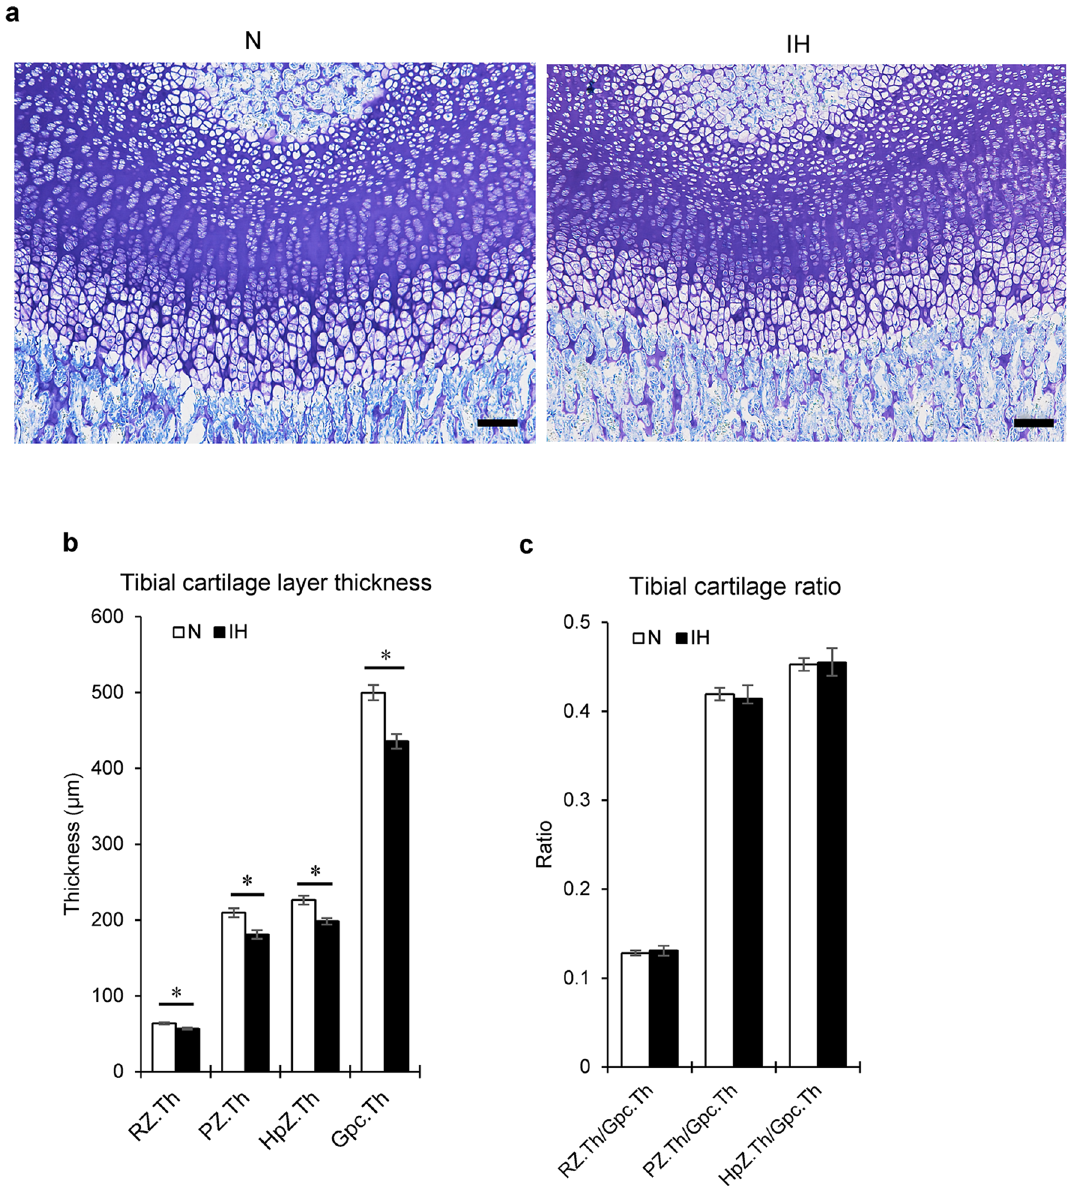
Figure 6. Histological changes in tibial cartilage of IH rats. ( a ) Representative images of toluidine blue-stained longitudinal sections of tibial cartilages from the N and IH groups. ( b ) Comparison of thicknesses of cartilage layers and growth plates between the N and IH groups. ( c ) Ratios of cartilage layer thickness to growth plate thickness. RZ.Th tibial cartilage layers, RZ.Th resting zone, PZ.Th proliferative zone, HpZ.Th hypertrophic zone, Gpc.Th height of growth plate. Scale bar = 100 μm. Data are mean ± SEM for each group. * P <